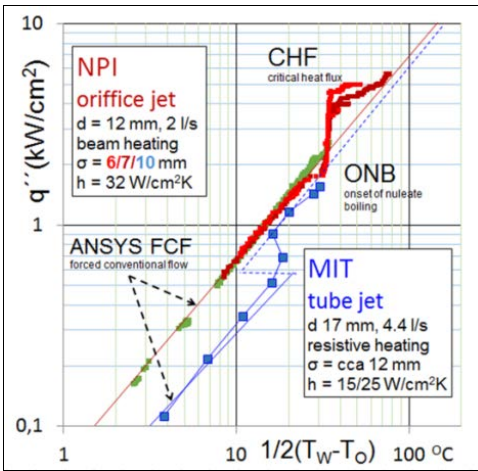
Fig. 7. Preliminary determined heat transfer characteristics of the submerged orifice jet cooling compared to long pipe-nozzle jet, developed at MIT BNCT neutron